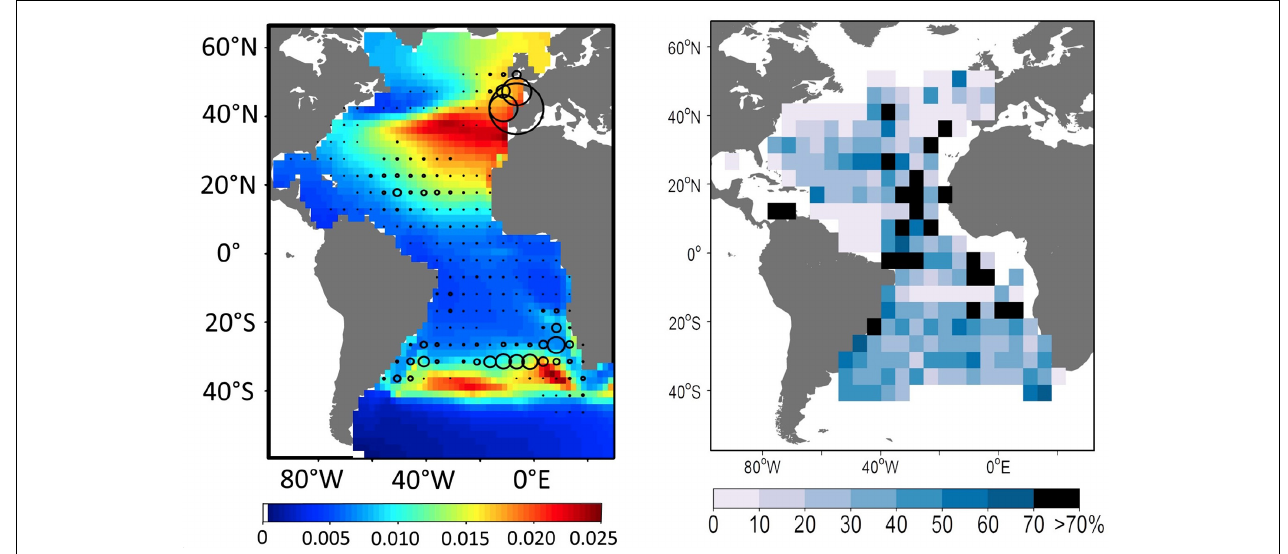
FIGURE 3 | The SEAPODYM (spatial ecosystem and population dynamics model) operational system supports near real-time prediction of albacore tuna stocks in the Atlantic. Left Density of adult fish (kg/km 2 ) and observed catch (circles) in July. Right Error in predicted total